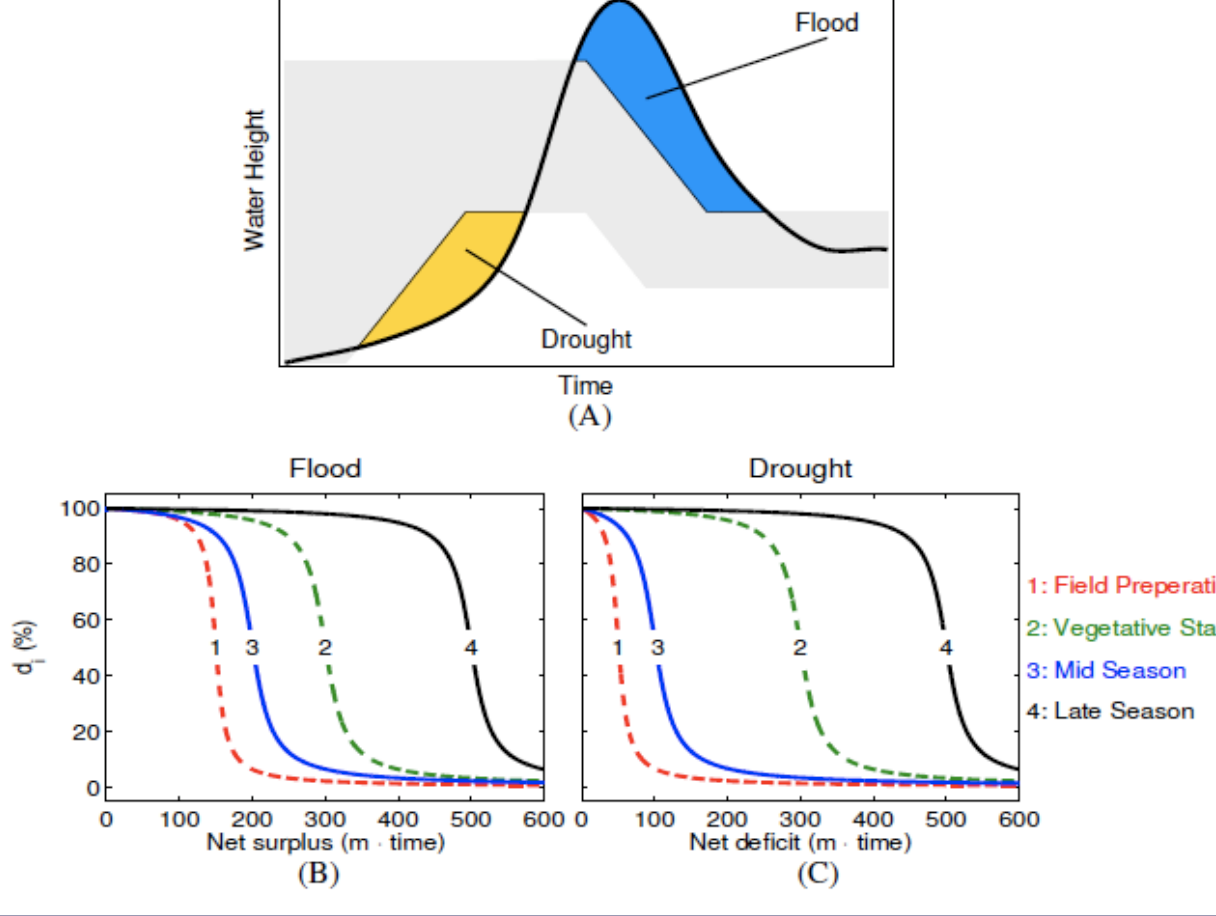
Fig. 5 . (A): Illustration of computation of cumulative drought (yellow area) and flood (blue area) events. (B-C): Performance measure coefficient functions for floods (B) and droughts